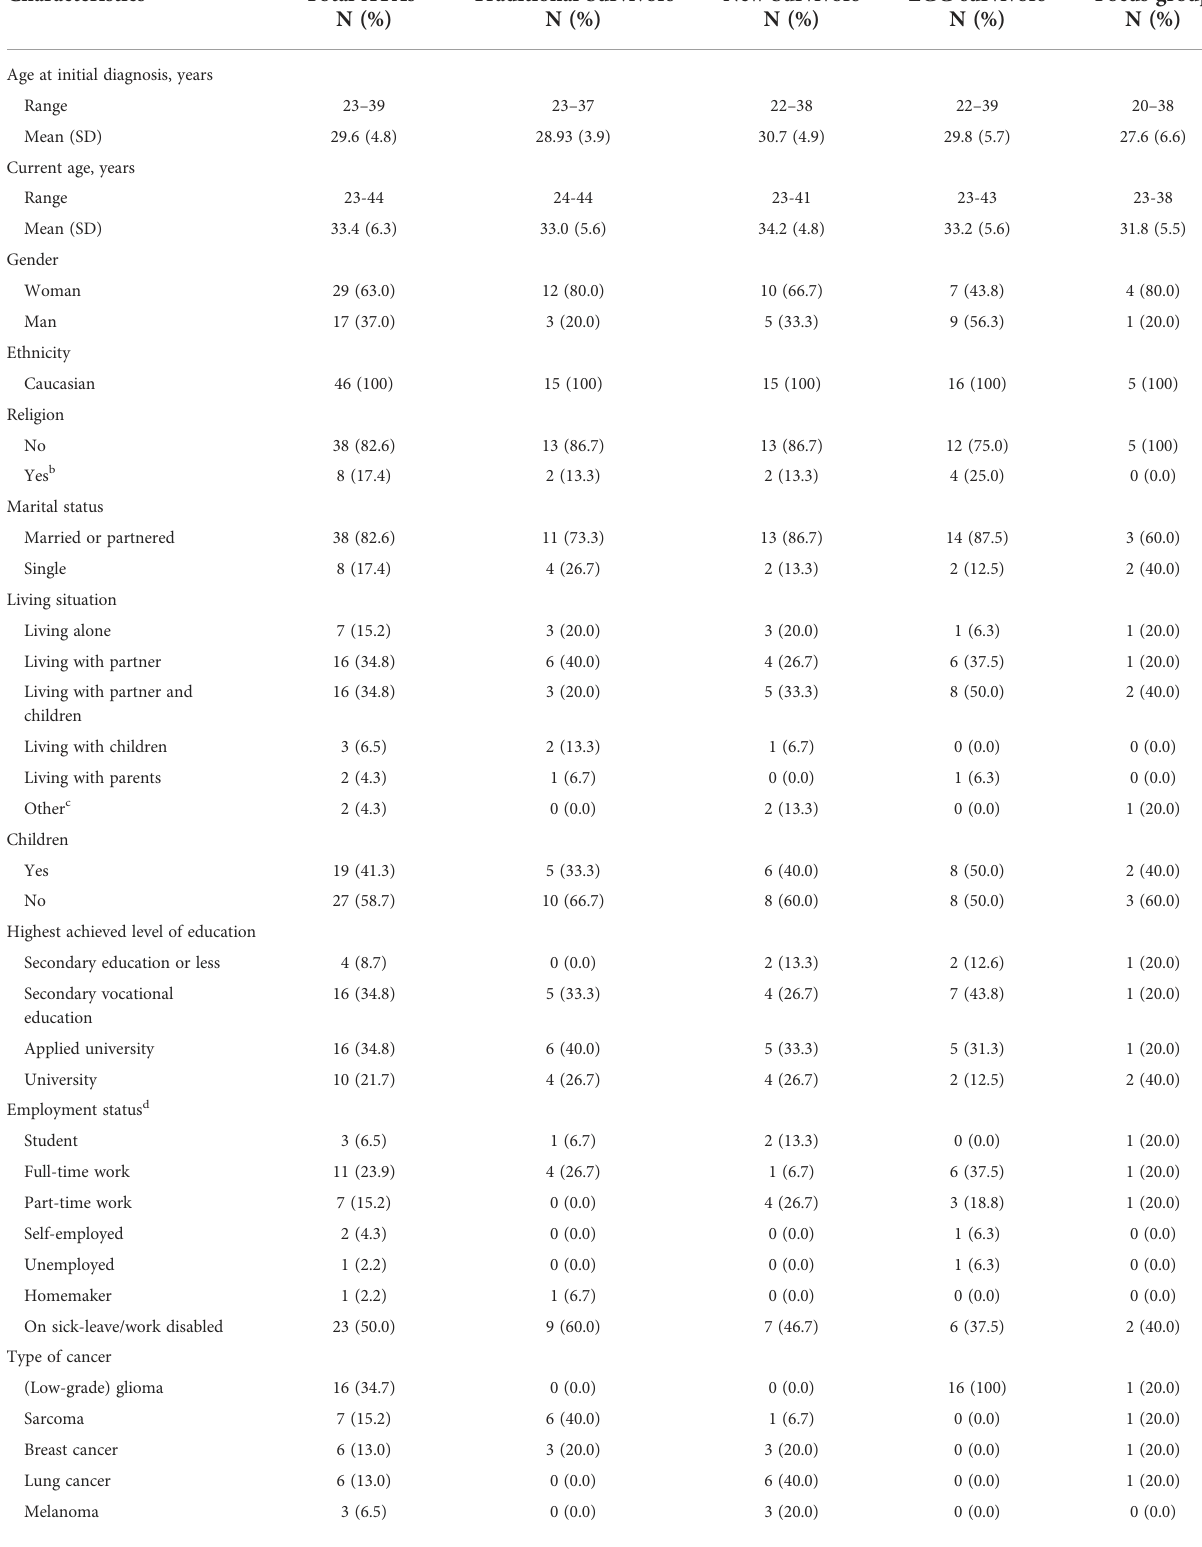
TABLE 2 Demographics AYA respondents and focus group of AYA research